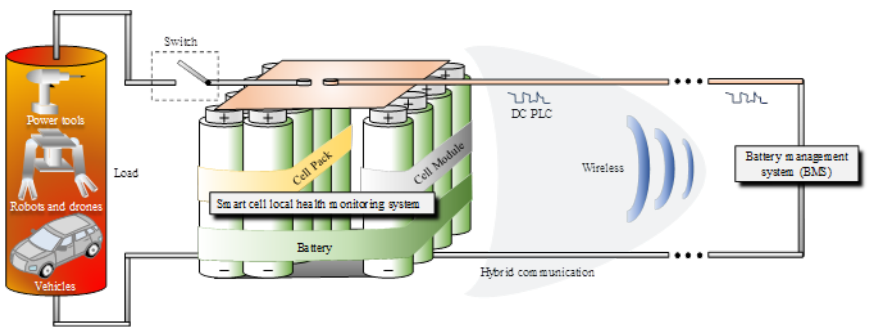
Figure 1. Battery monitoring system (BMS) research objectives.